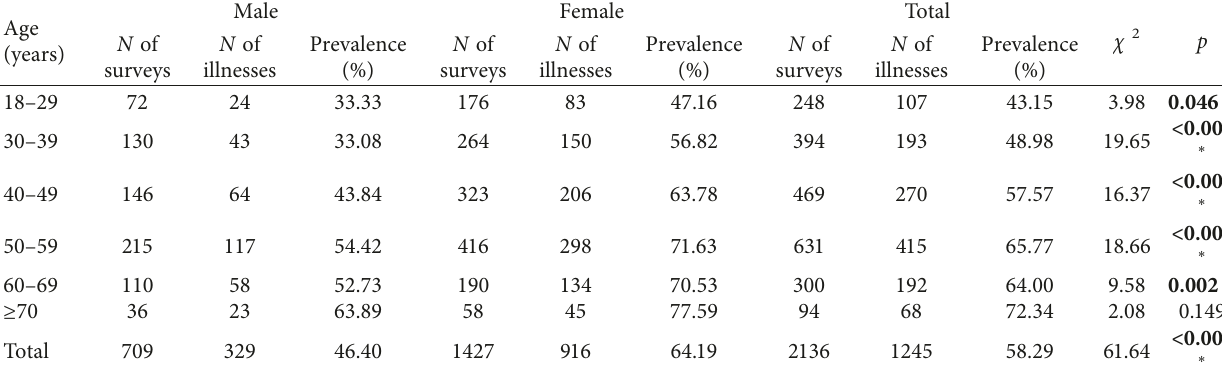
Table 3: Comparison of gender differences in the prevalence of thyroid diseases in different age groups.